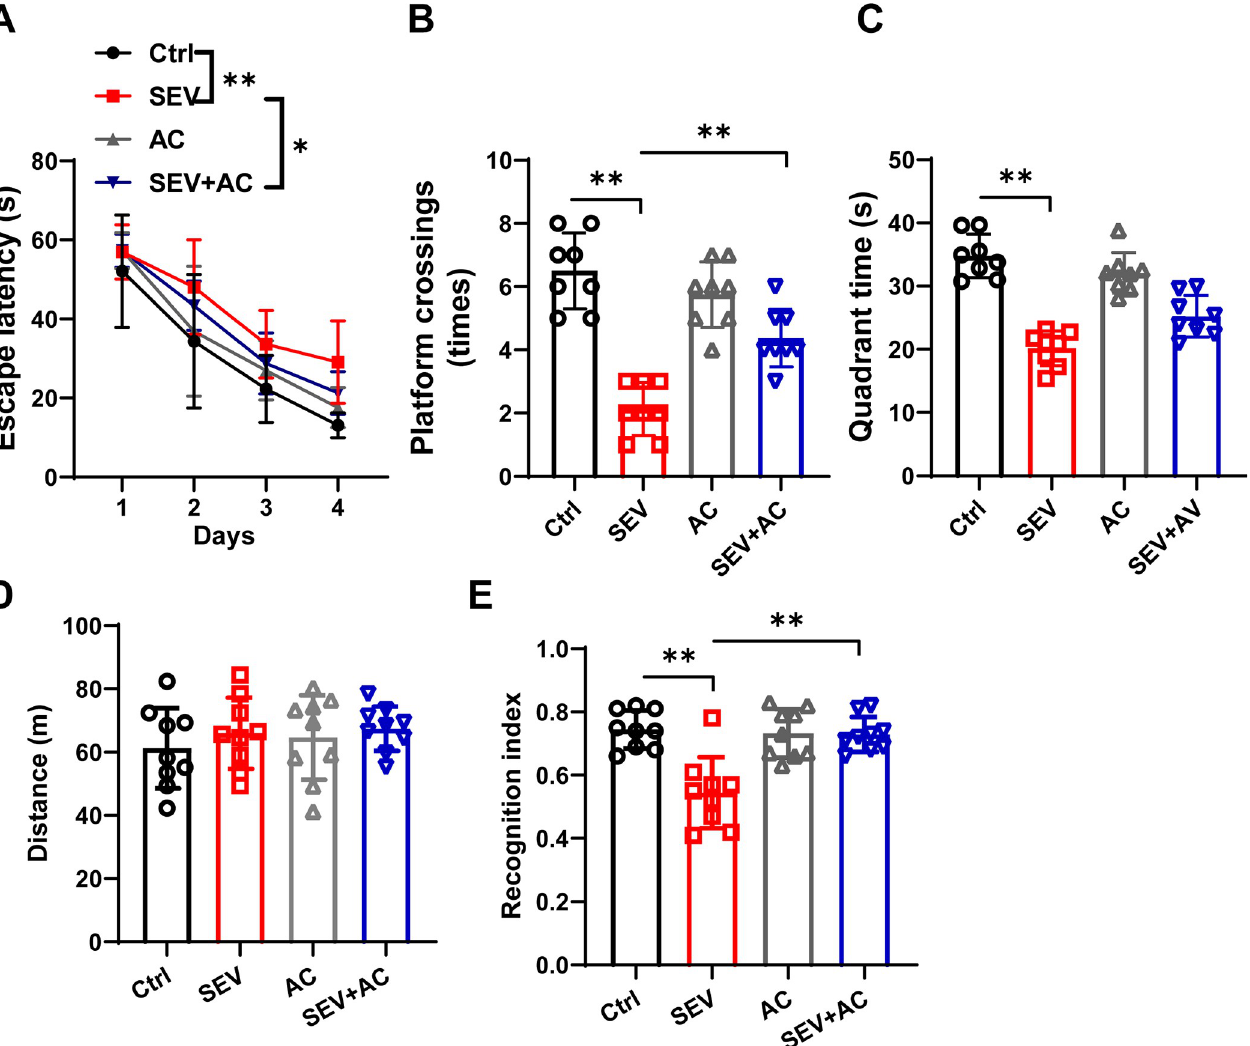
Fig 3. Ac-YVAD-cmk rescued learning ability impairment induced by sevoflurane in aged mice. Eighteen-month-old mice were subjected to 2% sevoflurane for 5 h. Ac-YVAD-cmk (12.5 μ mol/kg) was administrated intraperitoneally 1 h before sevoflurane treatment. The Morris Water Maze was used to test the learning ability. The parameters escape latency (A) number of platform crossings (B) and quadrant time (C) were measured. n = 8. The novel object recognition test was performance. The travelled distance (D) and recognition index (E) were shown. n = 9.The data are expressed as mean ± SD. � P < 0.05, �� P <